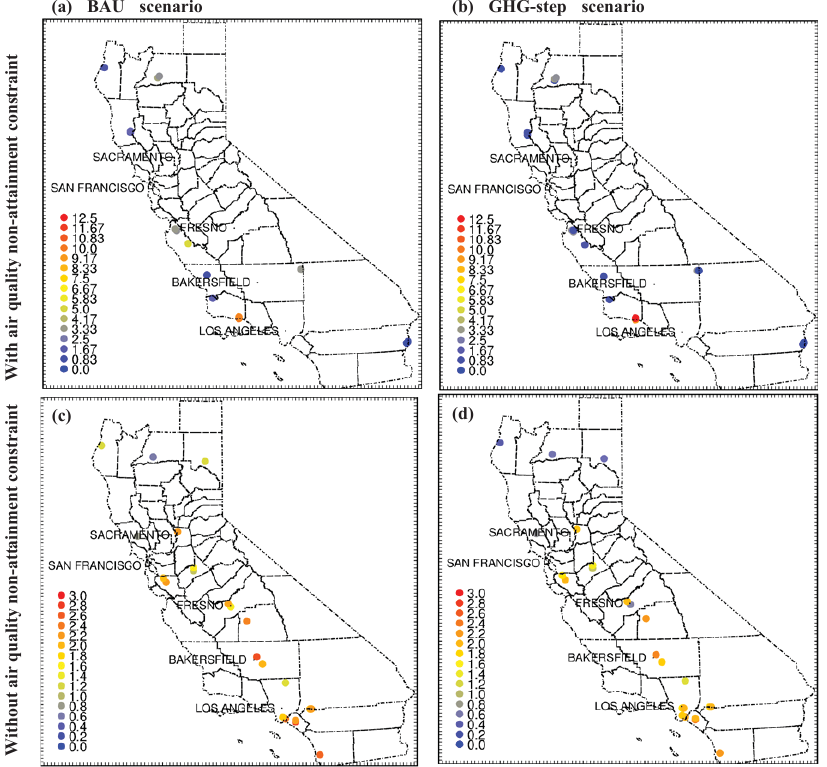
Figure 17. Biorefinery locations under the BAU scenario (a) and the GHG-Step scenario (b) . Legend shows PM 2 . 5 mass emissions rates per facility (µgm − 2 min − 1 ). Panels (a) and (b) represent the constrained case in which biorefineries cannot be located in air basins out of compliance with National Ambient Air Quality Standards (NAAQS). Panels (c) and (d) are not constrained by NAAQS